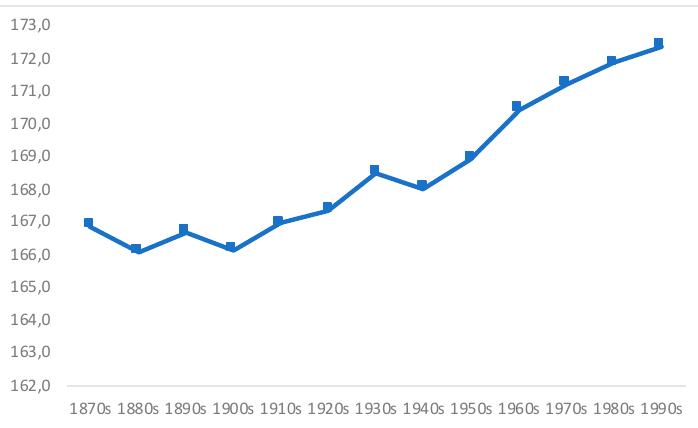
Figure 1. Raw average height of Chilean male adults (cms). Source [5,6].